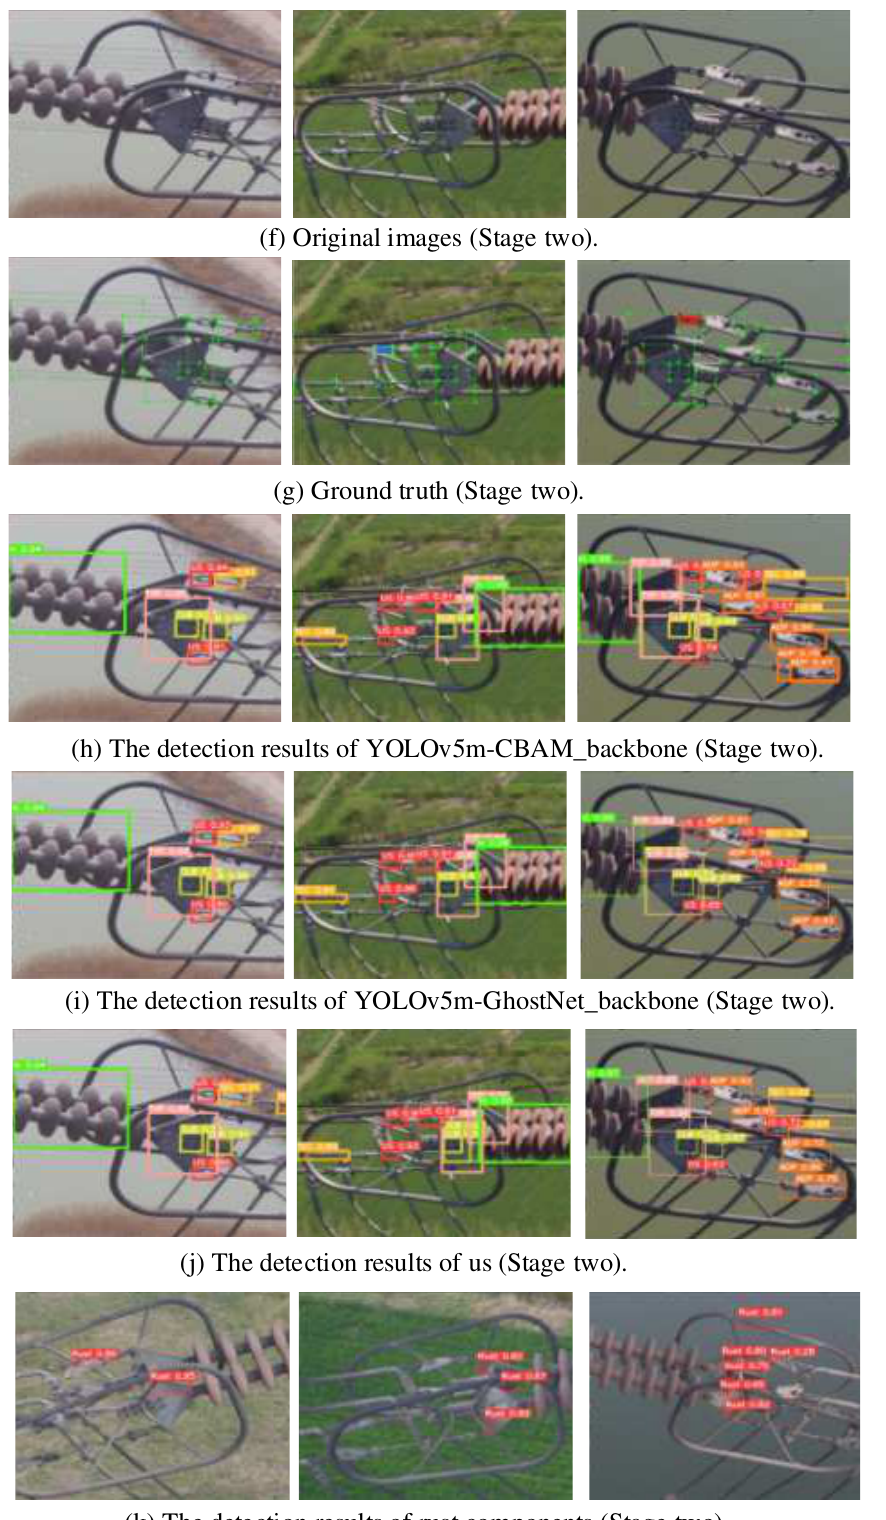
Figure 19. Model detection results. ( a – e ): stage one. ( f – k ): stage two.